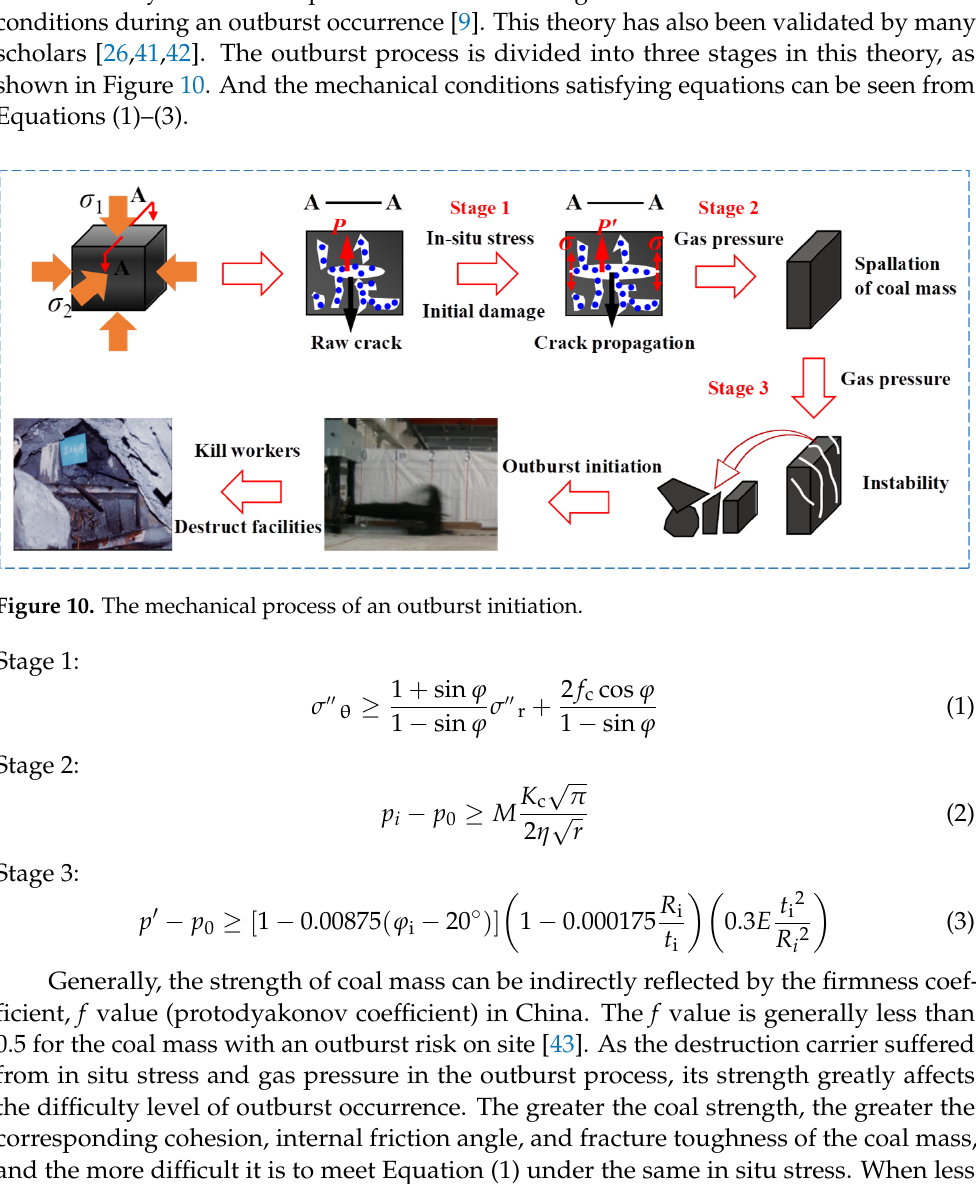
Figure 9. Comparison of gas velocity change vs. time under the same gas pressure between TD coal and PU coal.